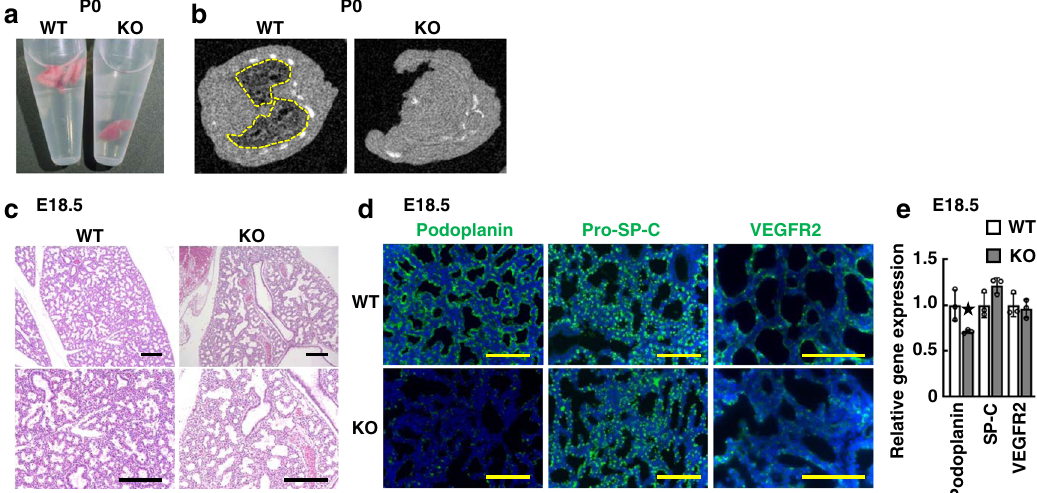
Fig. 4 Dyrk2 − / − mice exhibit respiratory failure due to lung hypoplasia. Dyrk2 − / − mice exhibit sudden death soon after birth due to respiratory failure and lung hypoplasia. a Neonate lungs of WT and Dyrk2 − / − mice. b Micro-CT analysis of the lung from P0 WT and Dyrk2 − / − pups. The dashed line; the area of lung in fl ation. c H&E staining of the lungs in E18.5 embryos. d Optical image of E18.5 lung in WT and Dyrk2 − / − embryos. Podoplanin (green), Pro- SP-C (green), VEGFR2 (green), and DAPI (blue). e Relative expression of genes related to AEC I and II makers in E18.5 lungs. Data are presented as the mean ± SD ( n = 3; * p < 0.05). Scale bar: 200 μ m ( c ) and 100 μ m ( d